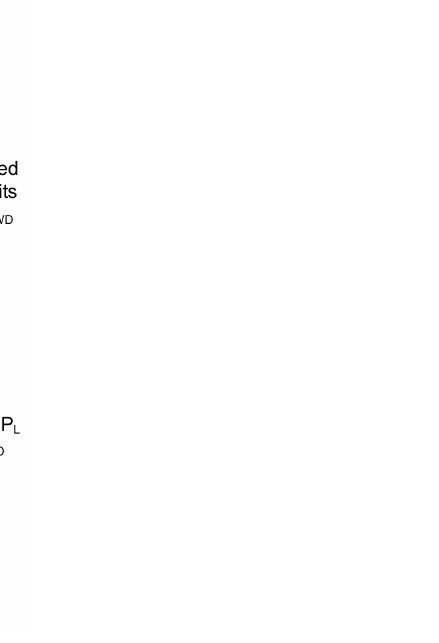
Figure 2. Wind diesel isolated microgrid (WDIM) operation modes and transitions between